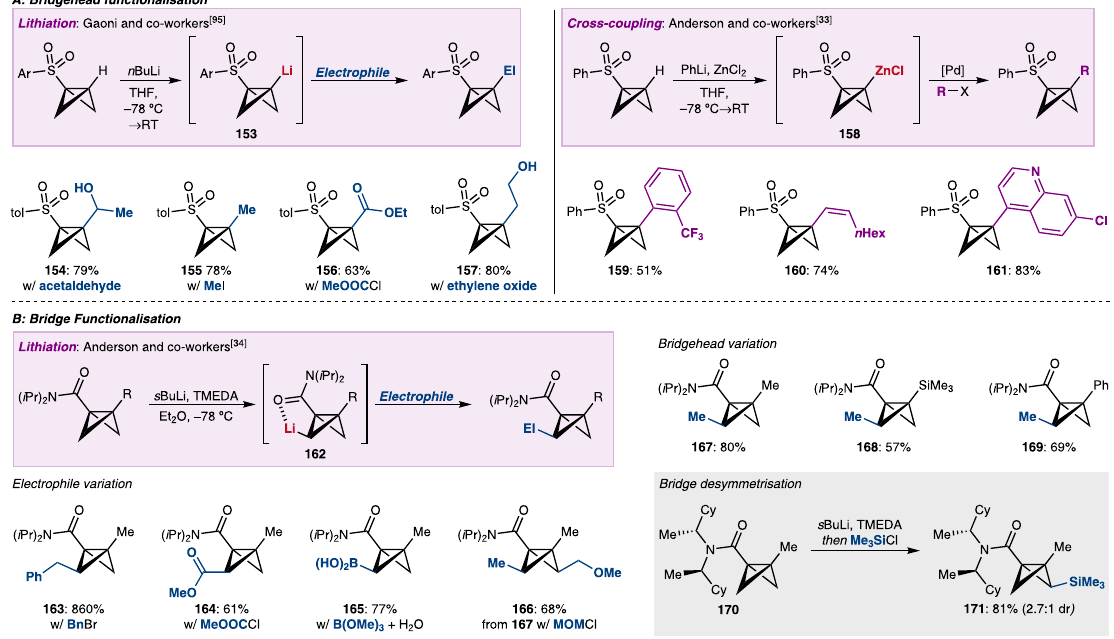
Fig. 7 Functionalisation reactions of BCBs to give highly substituted BCBs. A Functionalisation of the bridgehead position of bicyclobutanes by deprotonation with strong organolithium bases. The intermediates can then be trapped with typical electrophiles or, after transmetallation to zinc, be used in Pd-catalysed cross-coupling reactions. B Functionalisation of the bridge positions of bicyclobutanes by deprotonation with strong bases. Desymmetrisation of the bridge positions is also possible with chiral amide starting materials, leading to chiral bicyclobutane structures. El electrophile, Ar aryl, tol tolyl, TMEDA tetramethylethylenediamine, MOM